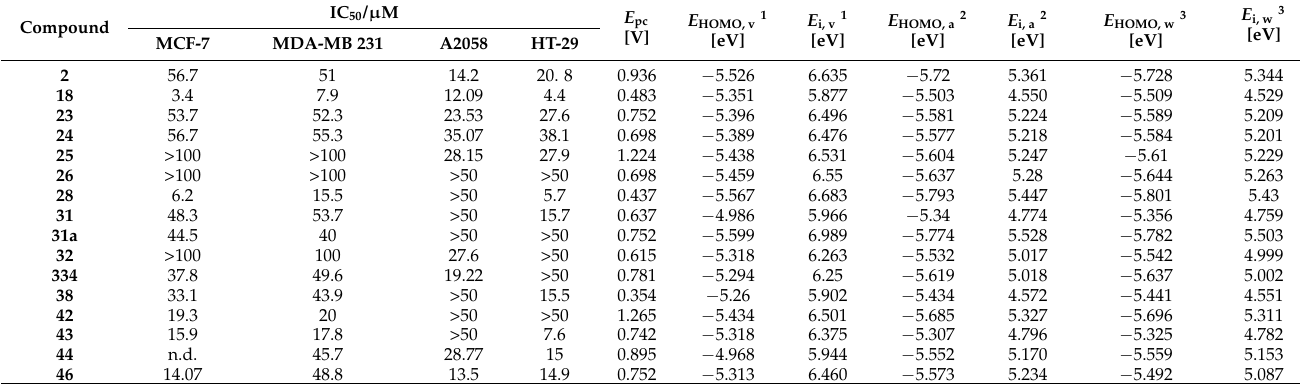
Table 1. Structure-activity analysis of the synthetised Tamoxifen analogues in terms of their in vitro cytotoxicity on four human tumor cell lines (expressed in IC 50 values) and their ROS-generating potency characterized by experimental cationic peak potentials ( E pc ) supplemented with E HOMO and adiabatic ionization energy ( E i ) resulted from DFT modeling studies.